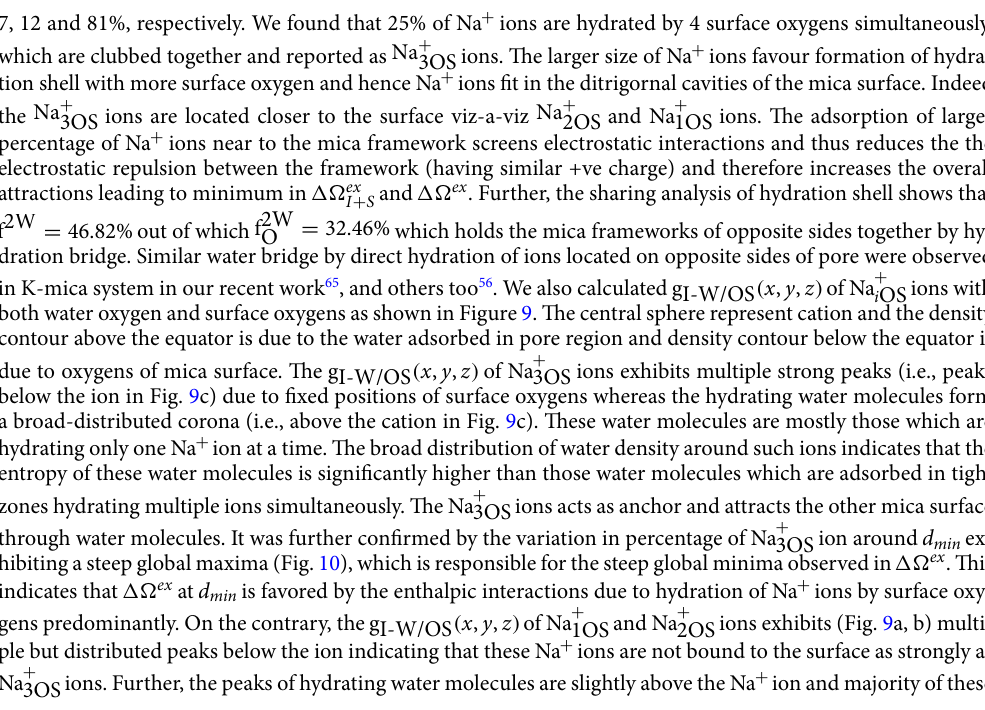
Figure 9. Hydration structure of cations in M-mica systems. Three-dimensional ion-oxygen (of water + mica) pair correlation function, gI-W/OS ( x , y , z ) , evaluated within the r min for cations hydrated by only one (M + + simultaneously two (M 2OS ) and three or more (M 3OS ) surface oxygens. The local density in gI-W/OS ( was normalised by ρ b for easy comparison across all cases. Iso-surfaces for selected values are shown by different semi-transparent colours (legend at bottom left). The central (red) sphere represent cation and density contour above and below the equator are due to oxygens of water and mica, respectively. When cation hydration by + surface atom is more and stronger (as in Na 3OS ), the hydration by water is mobile and distributed forming + water. The distributed peak below H 1OS ion is due to mobility of